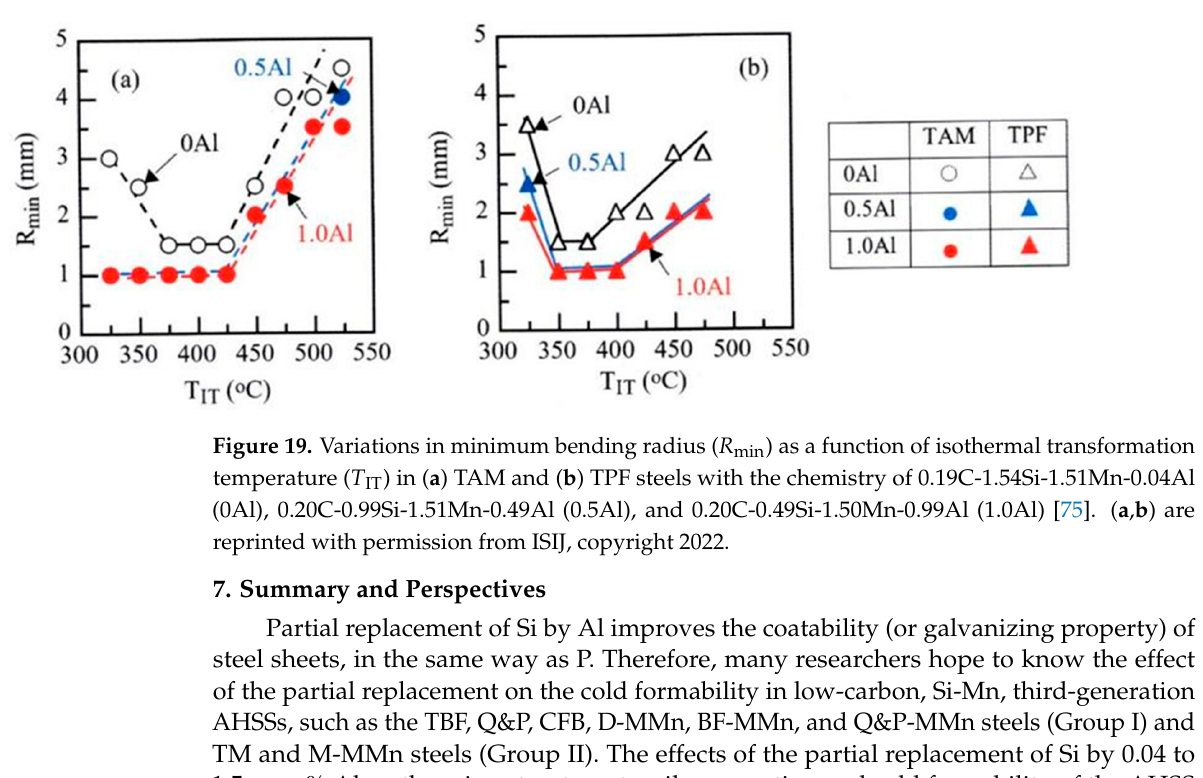
18 of 24 Figure 18. Relationships between minimum bending radius ( R min ) and tensile strength (TS) in ( a ) 0.21C-1.449Si-1.50Mn-1.0Cr-0.05Nb TBF and TM steels ( ● ), 0.082C-0.88Si-2.0Mn ferrite-martensite DP steel ( ◇ ), and 22MnB5 Q&T steel ( ⊠ ) [52] and ( b ) (0.1-0.6)C-1.5Si-1.5Mn TPF ( ○ ), TAM ( □ ), and TBF ( △ ) steels [99]. ( a ) is reprinted with permission from AIST, copyright 2022. ( b ) is reprinted with permission from ISIJ, copyright 2022. 6.2. C-Si/Al-Mn Steel Unfortunately, there are not any results on the effect of partial replacement of Si by Al on the bendability in the third-generation AHSSs. However, research investigating the effect of Al content on the R min in the first-generation AHSSs was reported by Sugimoto et al. [75]. Figure 19 shows the effect of Al content on R min − T IT relation in 0.2C-(0.5-1.5)Si- 1.5Mn-(0.04-1.0)Al TPF and TAM steels with TS between 700 and 1000 MPa [75]. Partial displacement by 0.5 and 1.0 mass% Al under a condition of Si+Al = 1.5 mass% reduced the R min in both sheets of steel. The optimum bendability was obtained in the TAM steel sub- jected to the IT process at temperatures between 275 and 425 °C, in the same way as the